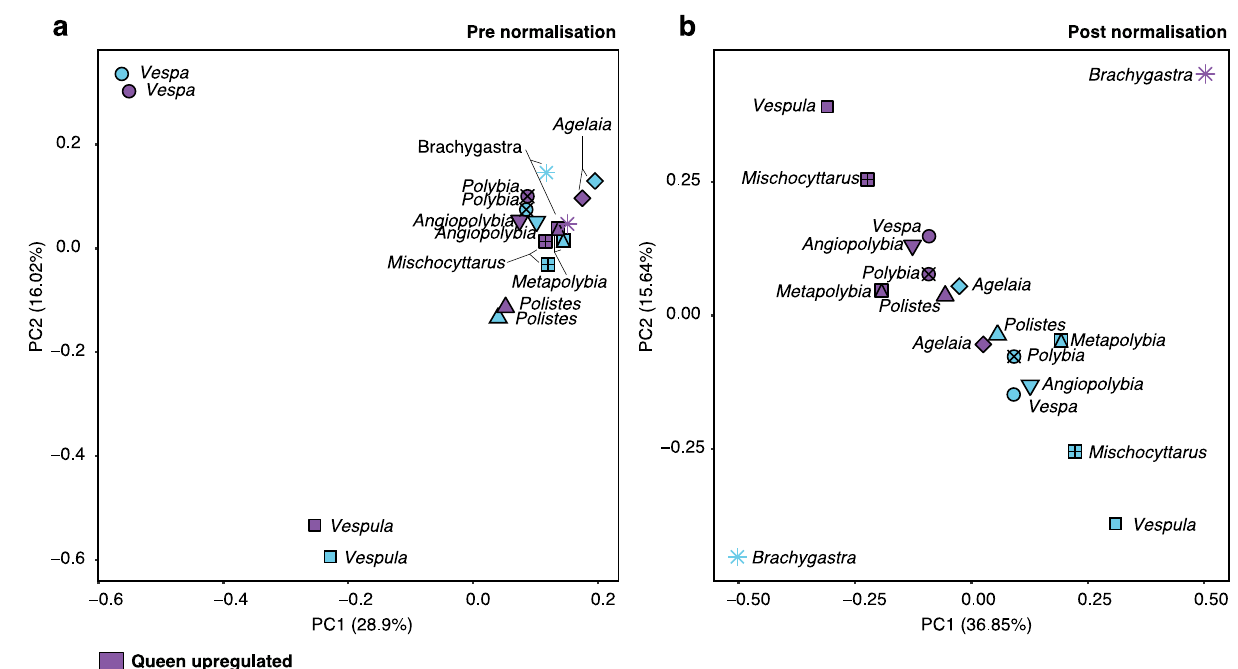
Fig. 2 | Principal component analyses of orthologous gene expression before and after between-species normalisation. a Principal component analyses per- formed using log2 transcript per million (TPM) gene expression values. This ana- lysis used single-copy orthologs (using Ortho fi nder), allowing up to three gene isoforms in a single species to be present, whereby we took the most highly expressed to represent the orthogroup, as well as fi ltering of orthogroups which